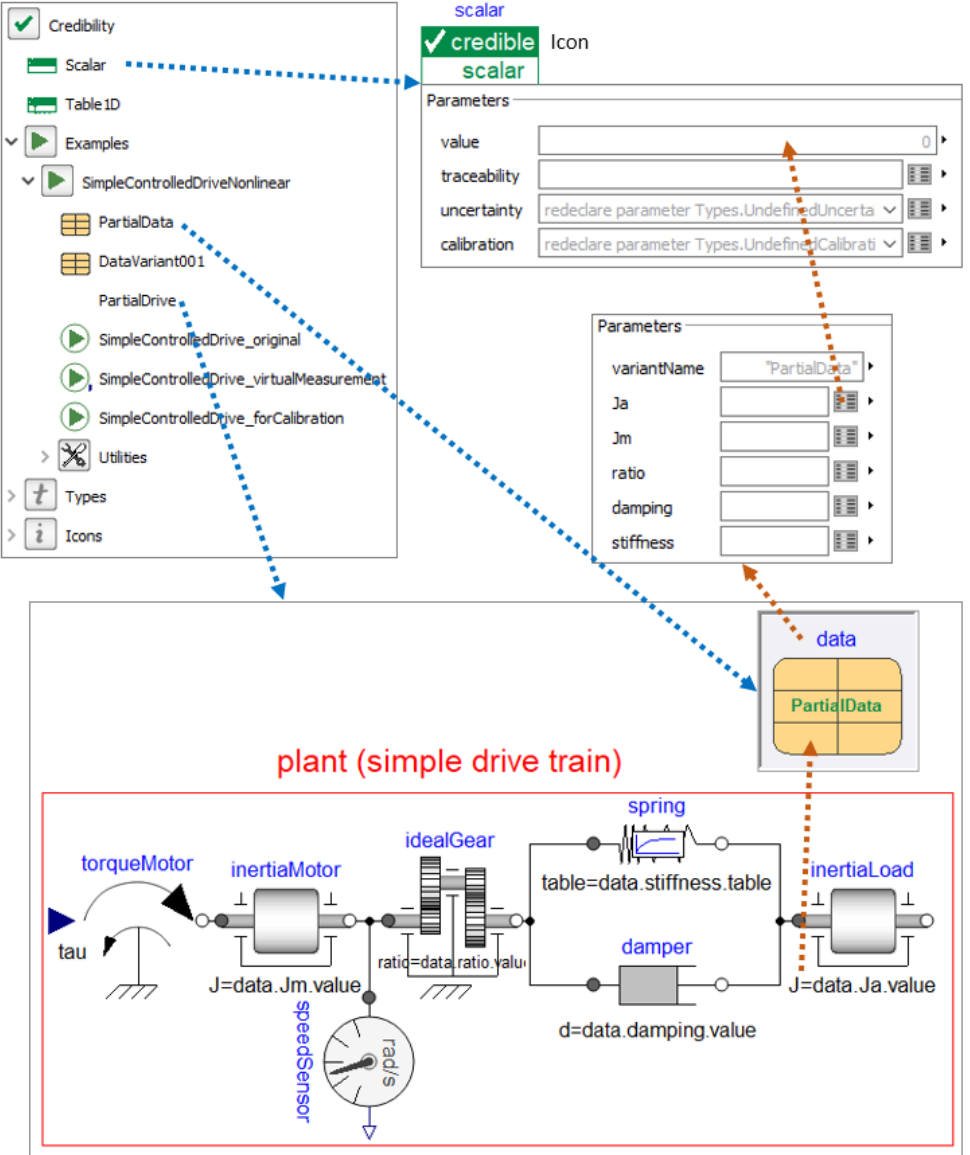
Figure 7. A screenshot of Modelica library Credibility . In the upper left part, the library is shown and in the lower part, the simple, nonlinear example model Credibility.Examples.SimpleControlled- DriveNonlinear.PartialDrive of a drive train. In the upper right part, the parameter menus of instance data are shown, which are present in PartialDrive . This instance does not yet con- tain data values for the parameters. Elements Ja , Jm , ratio and damping are instances of record Credibility.Scalar (shown in the upper right part). Element stiffness is an instance of the record Credibility.Table1D that is shown in Figure